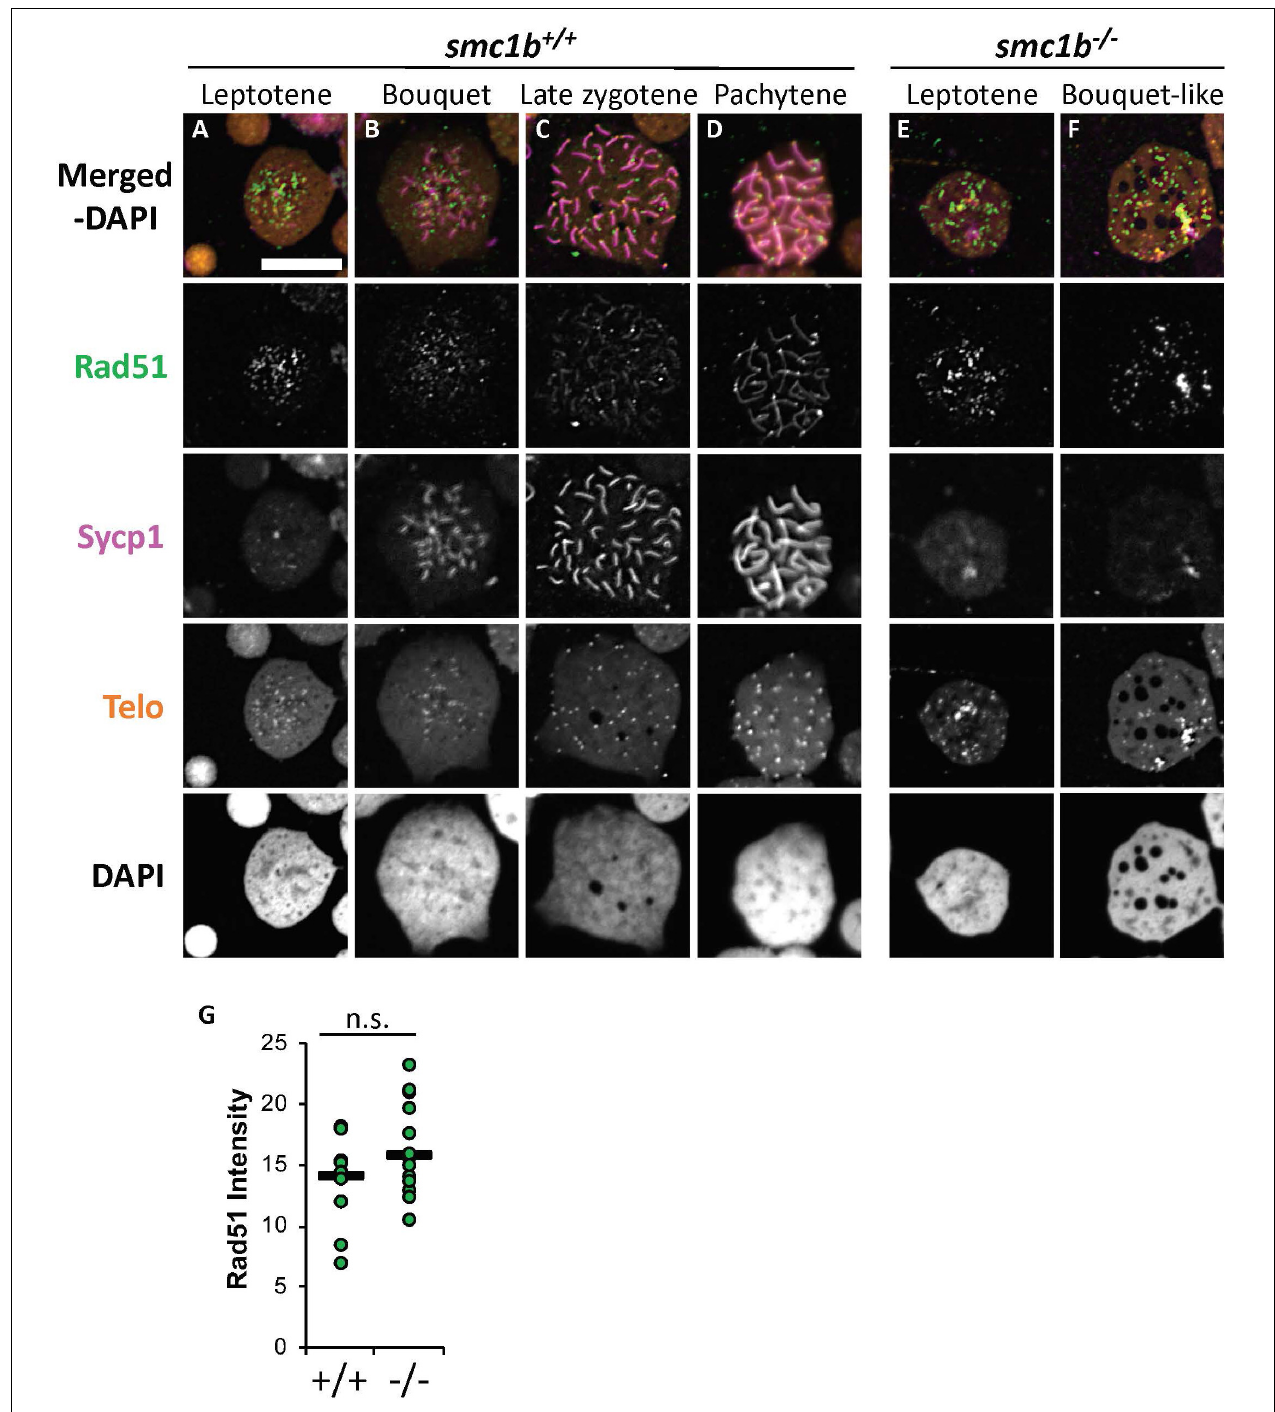
FIGURE 9 | DNA double strand break and recombination marker Rad51 was expressed in smc1b Q198X mutant spermatocytes. Immunolabeling of Rad51 (green) and Sycp1 (magenta) in wild-type and mutant spreads, combined with telomere (telo) in situ hybridization (orange). (A,B) Rad51 protein was detected in wild-type beginning in leptotene stage and was initially located near the chromosome ends in leptotene and bouquet stages. (C,D) In more advanced wild-type spermatocytes, Rad51 localization become more distinct and resolved to one or two spots per chromosome. (E,F) Mutant spermatocytes had detectable levels of Rad51. (G) Quantification of Rad51 signal in wild-type ( N = 10) and mutant ( N = 15) leptotene stage cells demonstrates there is no significant difference ( P = 0.0614). The horizontal bars show the medians. Scale bar is 10 µ m.